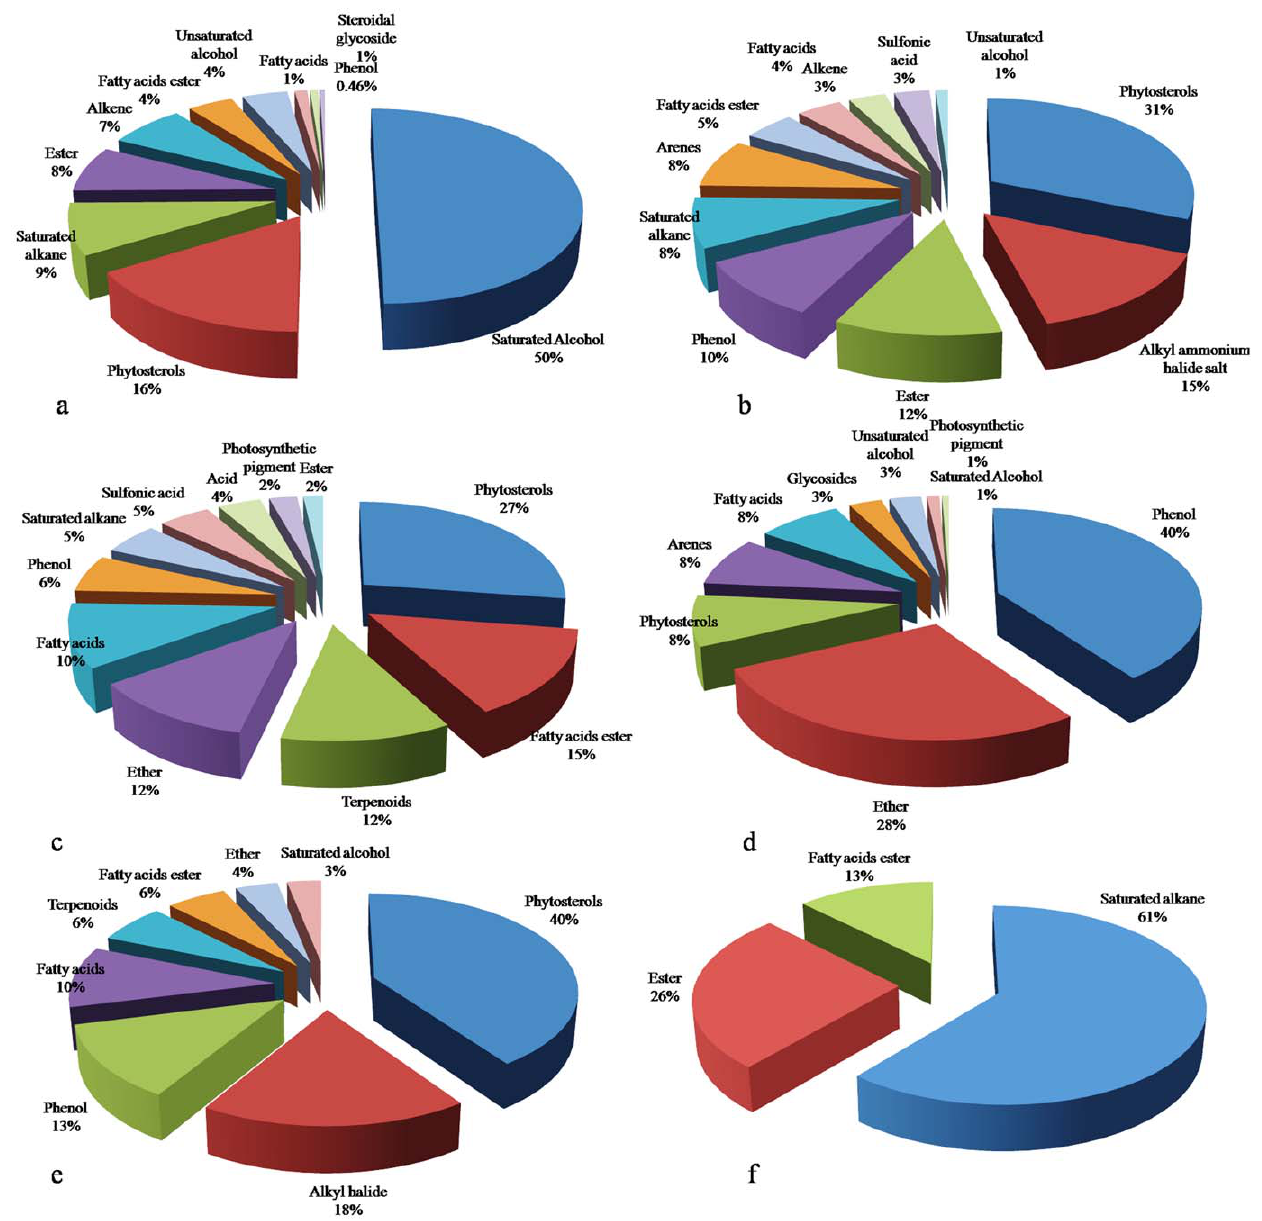
Figure 7. Estimation of major phytochemical groups in different root extracts of R.imbricata , a) n-hexane extract, b) chloroform extract, c) dichloroethane extract, d) ethyl acetate extract, e) methanol extract, f) 60% ethanol